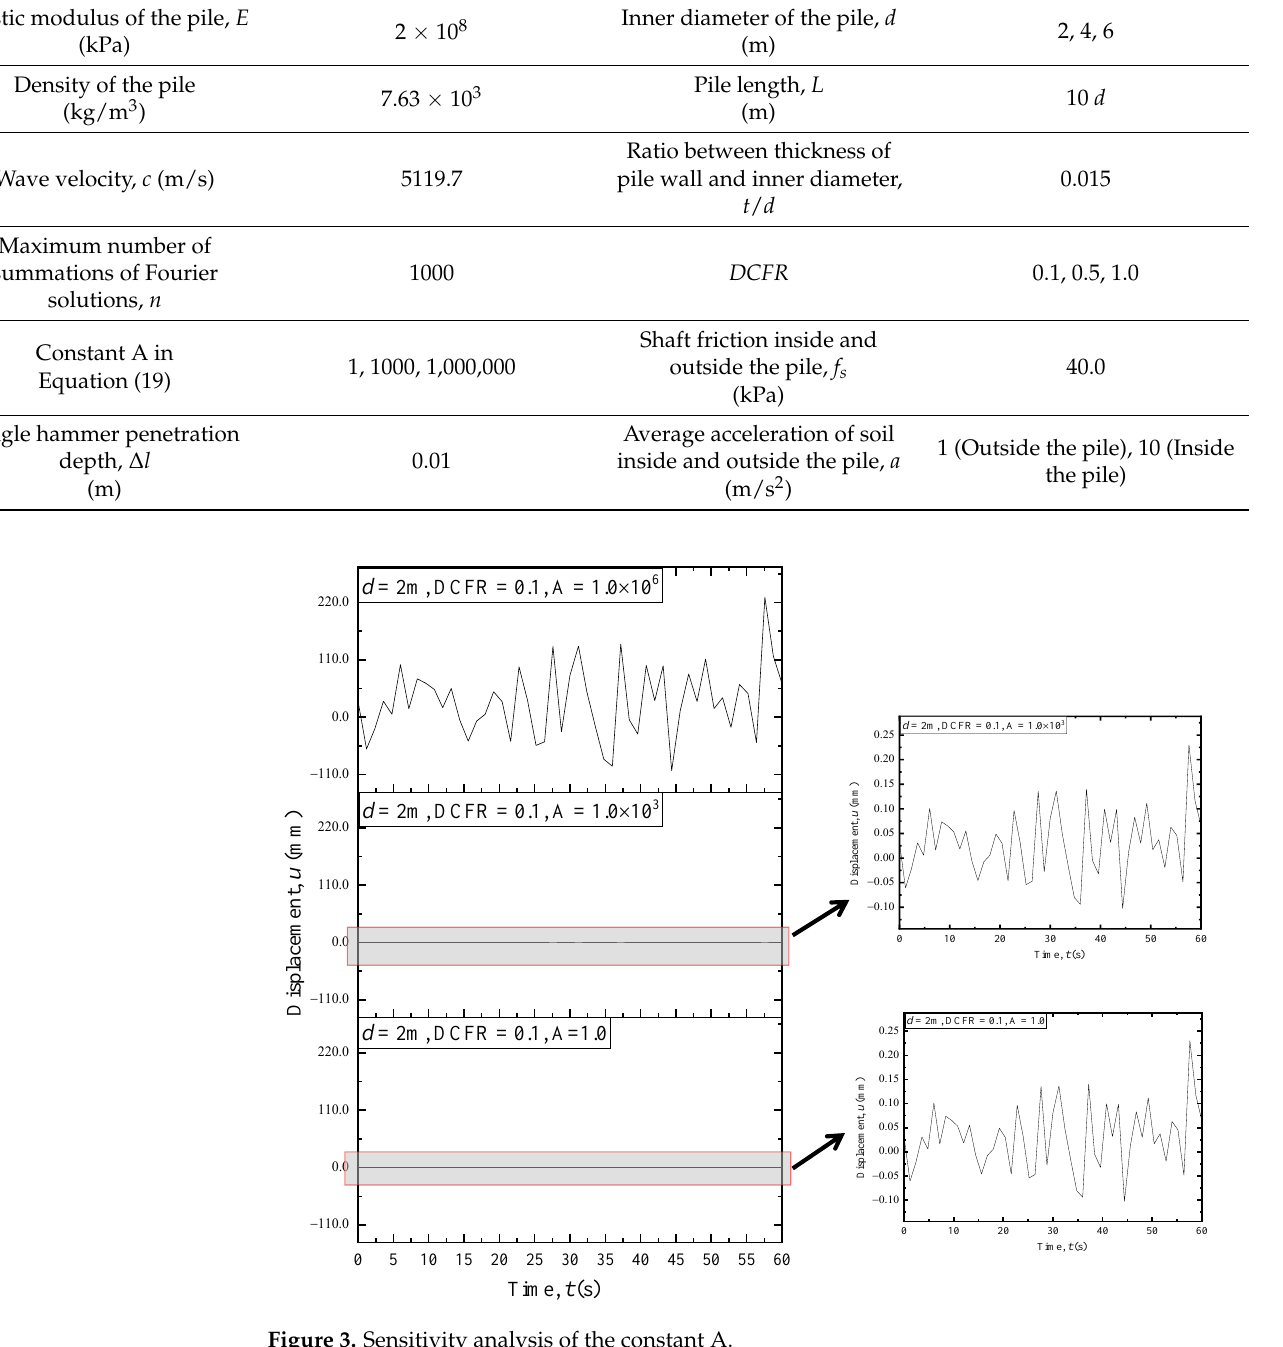
Figure 3. Sensitivity analysis of the constant